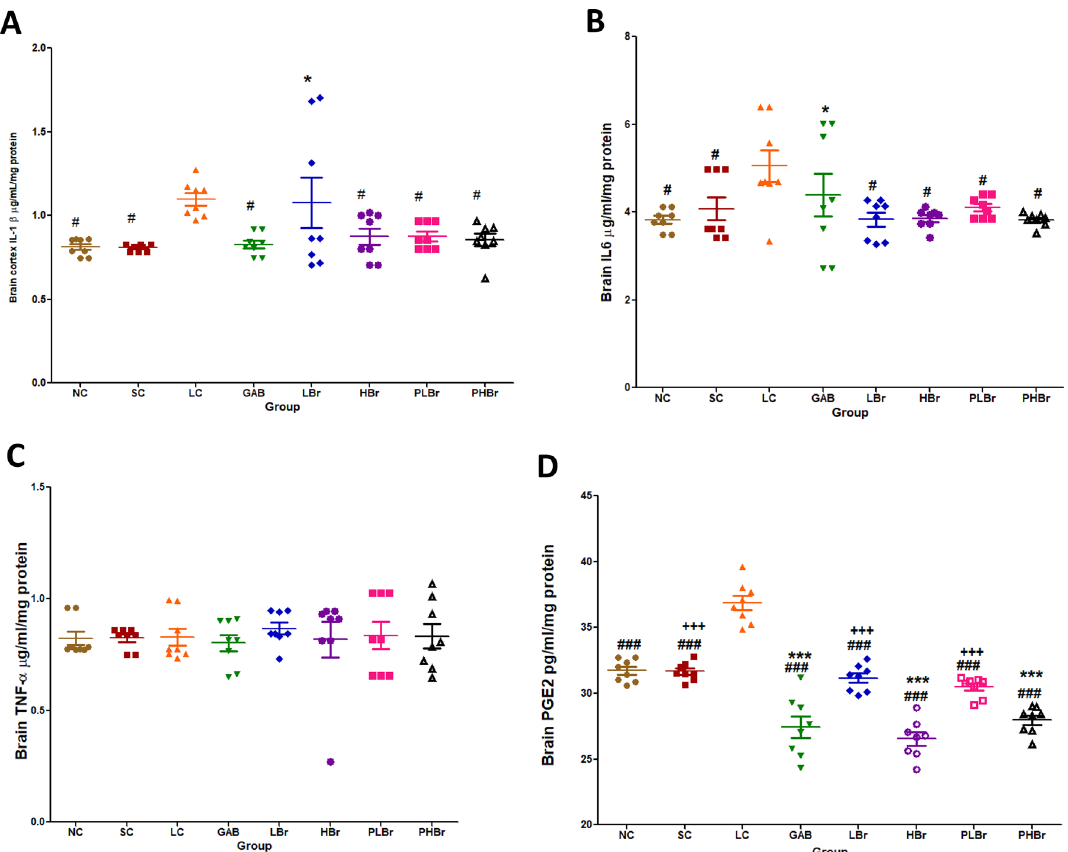
Figure 6. Effect of bromelain on pro-inflammatory mediators in the cerebral cortex. Each values represent mean ± SEM of each group (n = 8). ( A ) IL-1β concentration ( B ) IL-6 concentration ( C ) TNF-α concentration ( D ) PGE 2 concentration. # p < 0.05, ## p < 0.01, ### p < 0.001 compared with ligated control; *p < 0.05, **p < 0.01, ***p < 0.001 compared with normal control; + p < 0.05, ++ p < 0.01, +++ p < 0.001 compared with reference control. NC Unligated Normal Control, SC Sham Control, LC Ligated Control, GAB Gabapentin Reference Control (30 mg/kg gabapentin), LBr Low Dose Bromelain (30 mg/kg), HBr High Dose Bromelain (50 mg/kg), PLBr Pre- treated Low Dose Bromelain (30 mg/kg), PHBr Pre-treated High Dose Bromelain (50